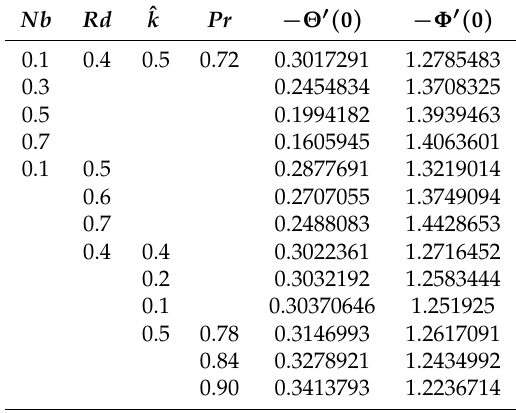
Table 3. Calculation of − Θ (cid:48) ( 0 ) and − Φ (cid:48) ( 0 ) for varying Nb , Rd , ˆ k , and Pr by keeping the remaining parameters